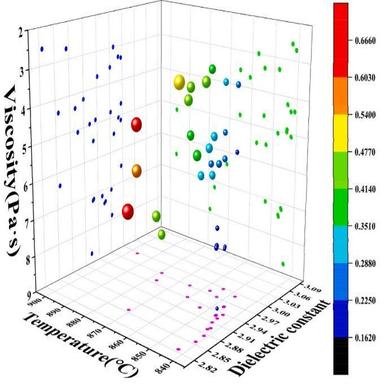
Normalised screening of the benzoxazine monomers.